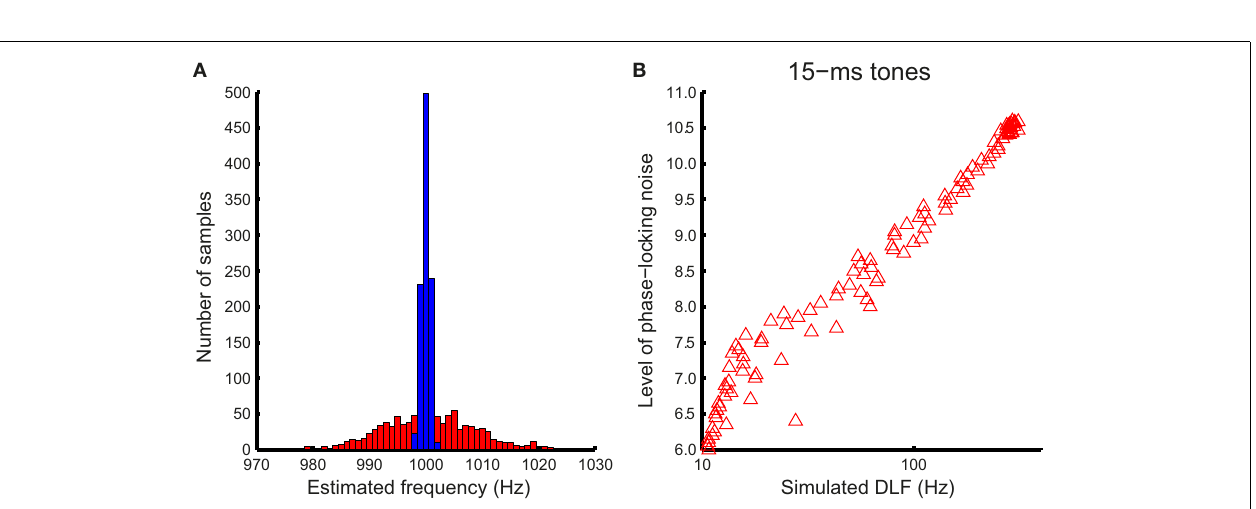
bars), and the entire stimulus for the 15-ms tone (red bars), obtained with 1000 iterations each. (B) The width (standard deviation) of the distribution was used to derive an estimated DLF for each noise level using SDT (in this case for 15-ms